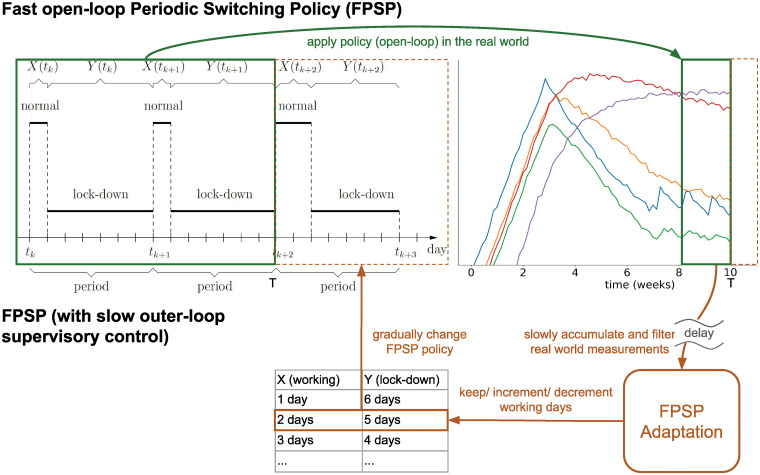
Illustrative scheme of the proposed mitigation strategy.(Green) an example of an FPSP with period T = 7 days (one week) is shown on the left in which two consecutive periods with [X, Y] = [1, 6] corresponding to a duty-cycle DC = 1/7 ≃ 14.3% (green box on the left) and a subsequent period with a different FPSP policy [X, Y] = [2, 5] corresponding to a duty-cycle DC = 2/7 ≃ 28.5% are shown (dashed orange box). The application of this FPSP influences the actual dynamics of the epidemics as shown on the right (long left-right arrow on the top). (Orange) delayed and possibly uncertain empirical measurements are collected (green box on the right) and used by the adaptive outer supervisory controller to select the specific FPSP policy (bottom right to left orange arrow) to be used in the subsequent time-period (bottom to top vertical orange arrow pointing to the new FPSP policy in the dashed orange box).